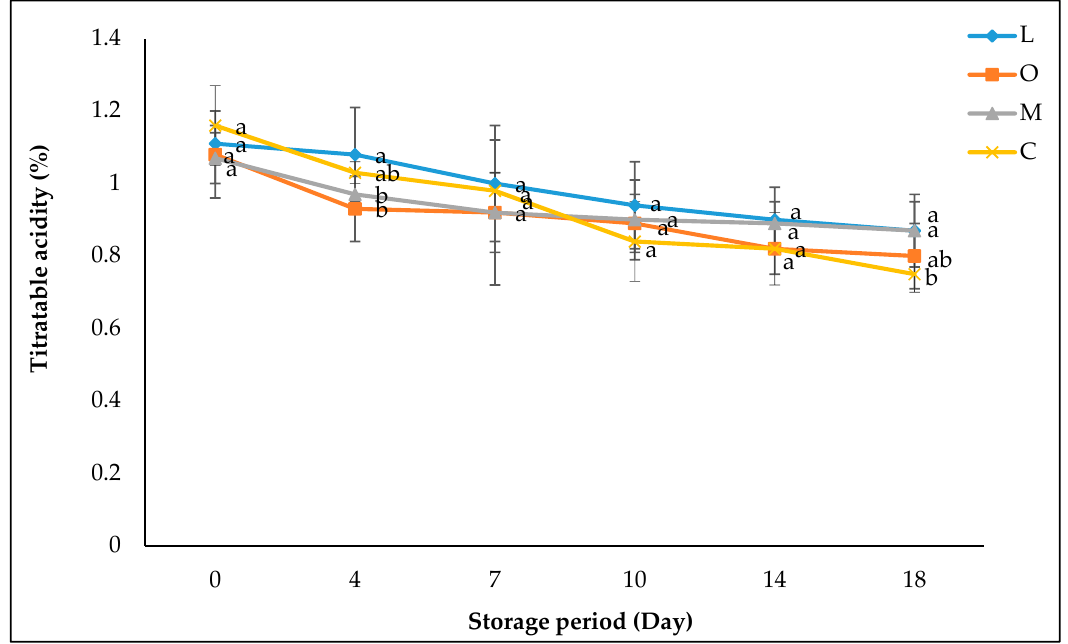
Figure 10. Effect of different essential oil emulsions (L = lemon, O = orange, and M = mandarin Figure 10. E ff ect of di ff erent essential oil emulsions (L = lemon, O = orange, and M = mandarin essential oil) on titratable acidity of strawberry fruits stored at 2 °C for 18 days. Vertical bars indicate essential oil) on titratable acidity of strawberry fruits stored at 2 ◦ C for 18 days. Vertical bars indicate the standard deviation (n = 6). Means and different letters indicate significant difference between the standard deviation (n = 6). Means and di ff erent letters indicate significant di ff erence between treated and control fruits at each storage period (Duncan’s of 95%). treated and control fruits at each storage period (Duncan’s of